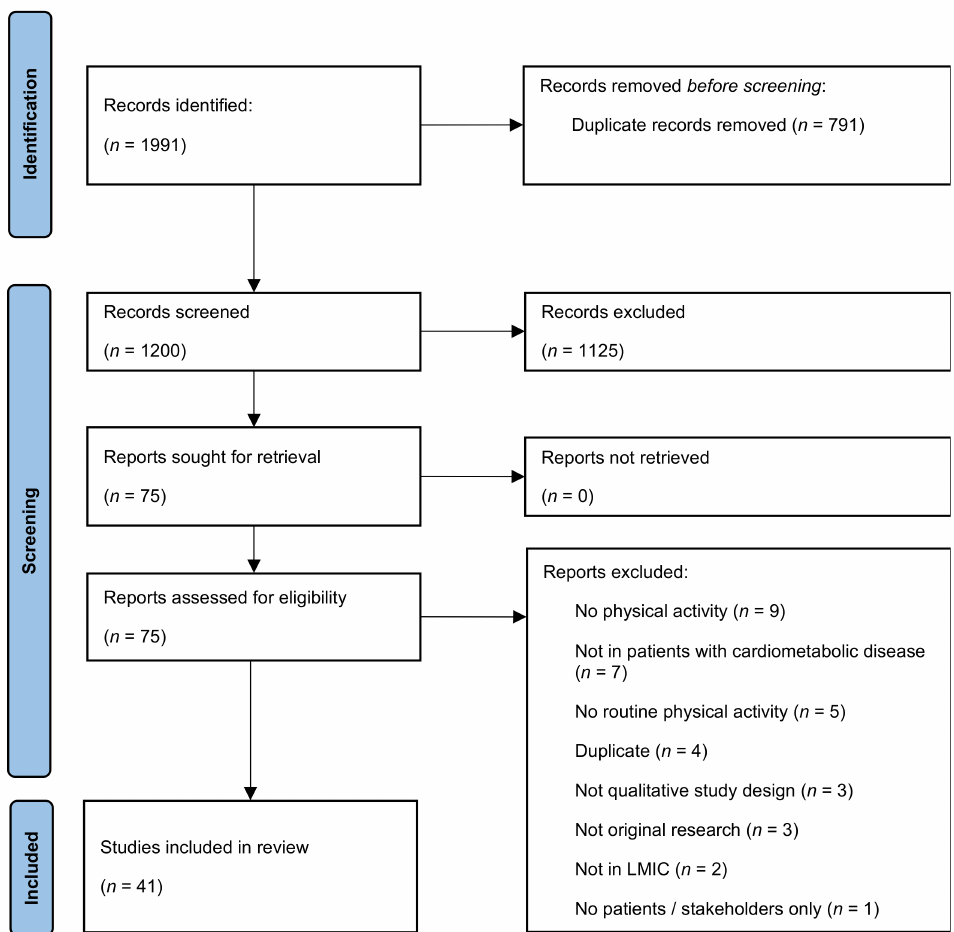
Figure 1. PRISMA flowchart. No studies were identified through other sources (e.g., citation screening). A total of 42 articles met inclusion criteria, reporting on 41 unique studies.